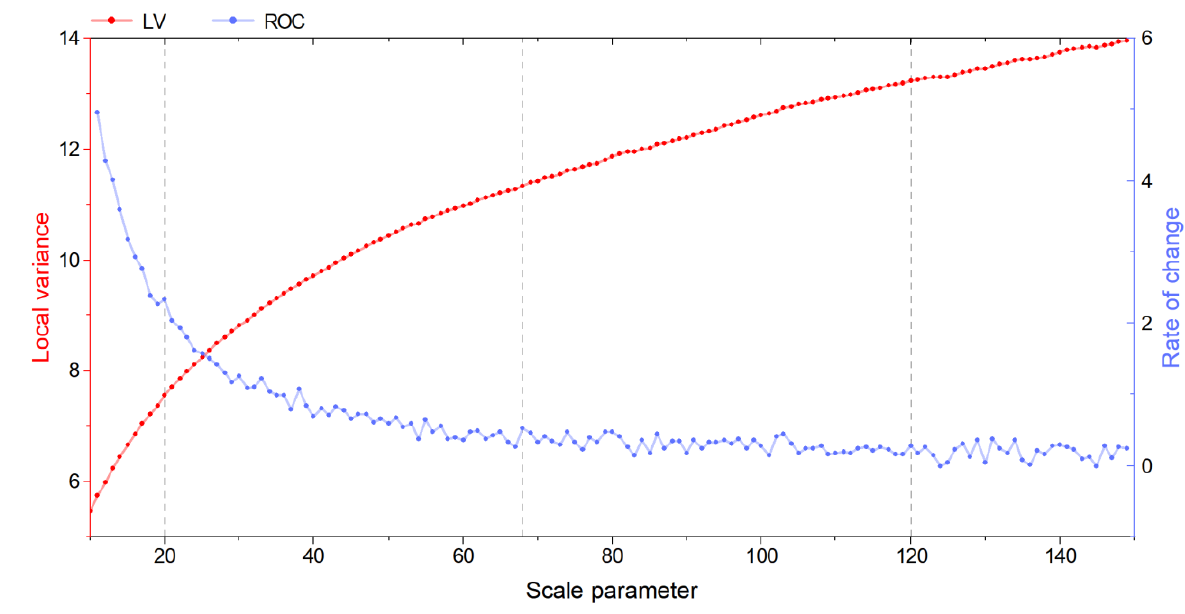
Figure 2. Changes of LV and ROC under different scale parameters.